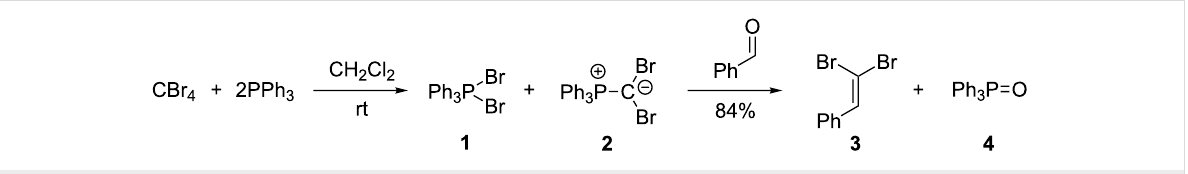
Scheme 1: Formation of gem -dibromoolefin 3 from the reaction of carbon tetrabromide and triphenylphosphine as reported by Ramirez et al.